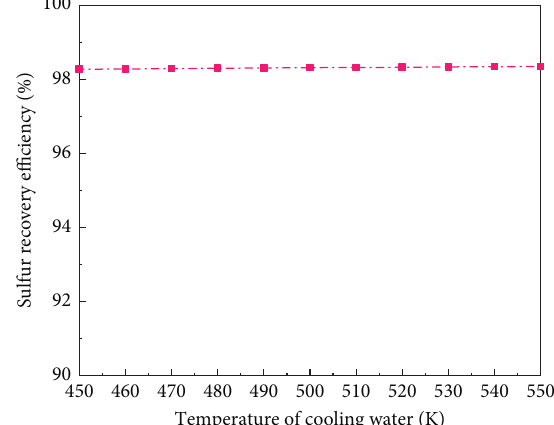
Figure 12: Sulfur recovery efficiency as a function of the tem- perature of cooling water.